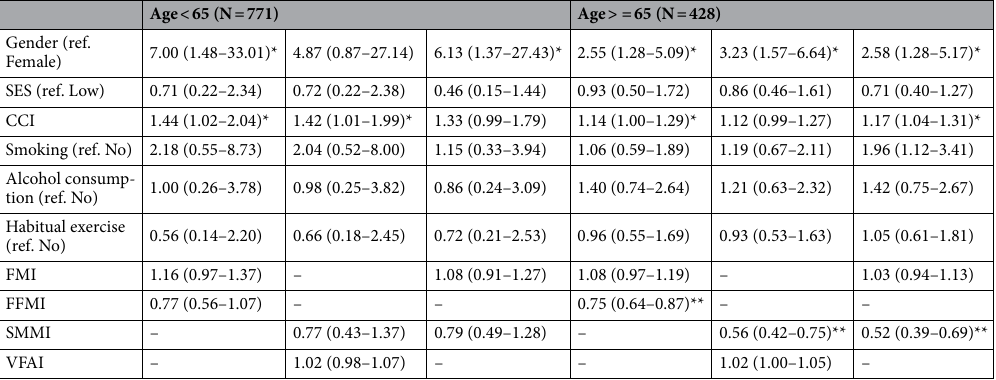
Age < 65 (N = 771) Age > = 65 (N = 428) Gender (ref. Female) 7.00 (1.48–33.01)* 4.87 (0.87–27.14) 6.13 (1.37–27.43)* 2.55 (1.28–5.09)* 3.23 (1.57–6.64)* 2.58